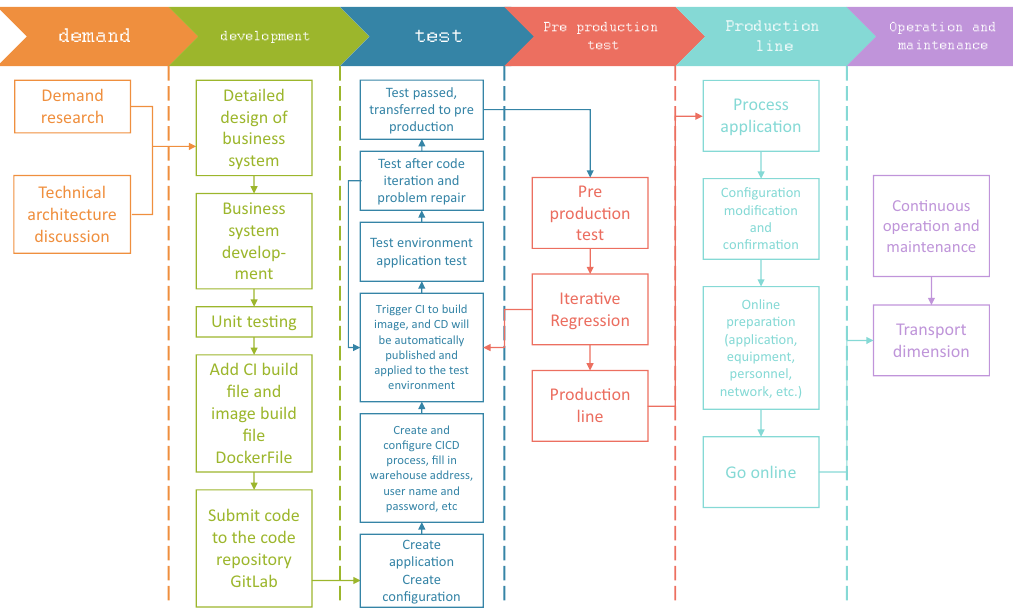
Figure 1: Software defect prediction